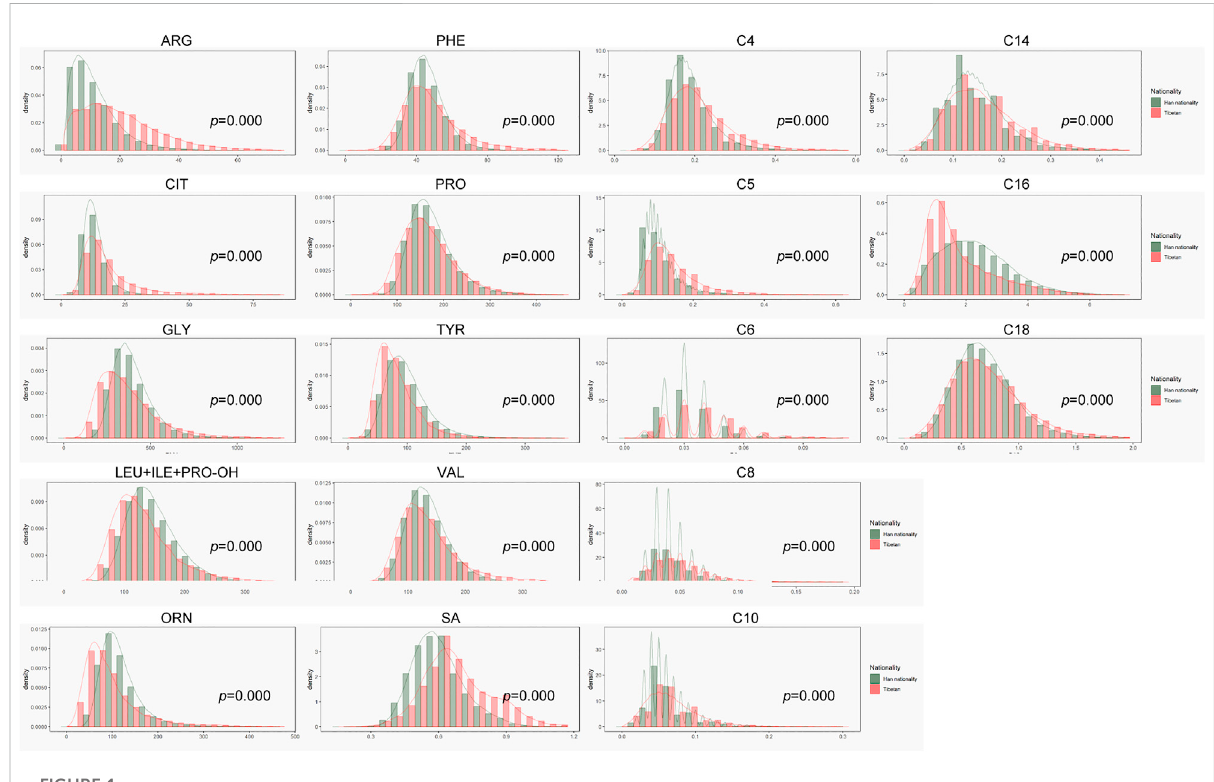
FIGURE 1 Comparison of data between samples from Tibet and our